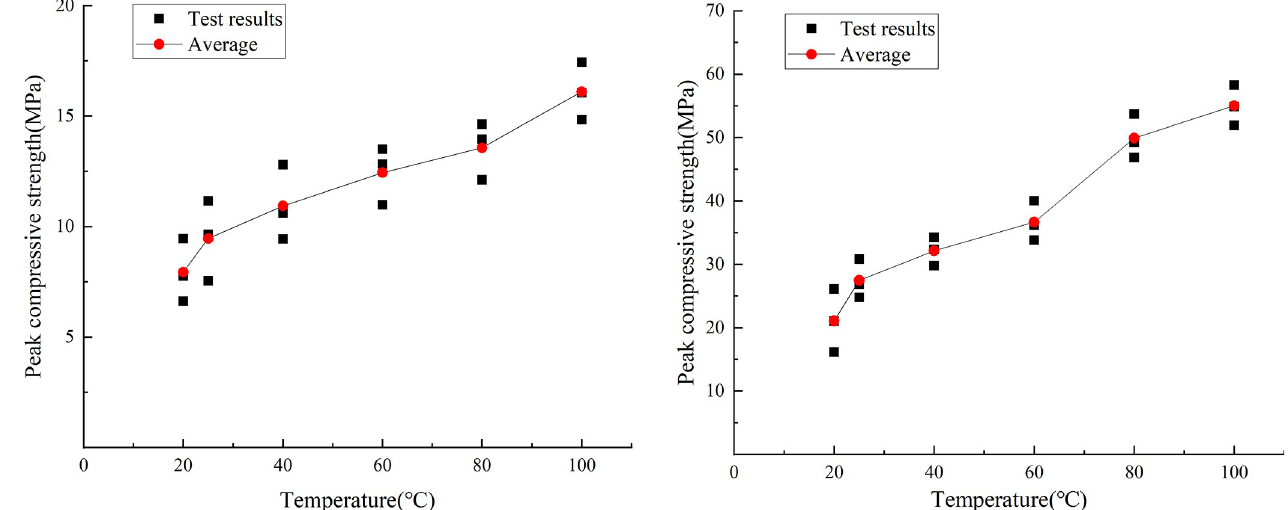
Fig 21. Curve of peak compressive strength at different temperatures. (a) Compressive strength responses of similar materials. (b) Raw rock.